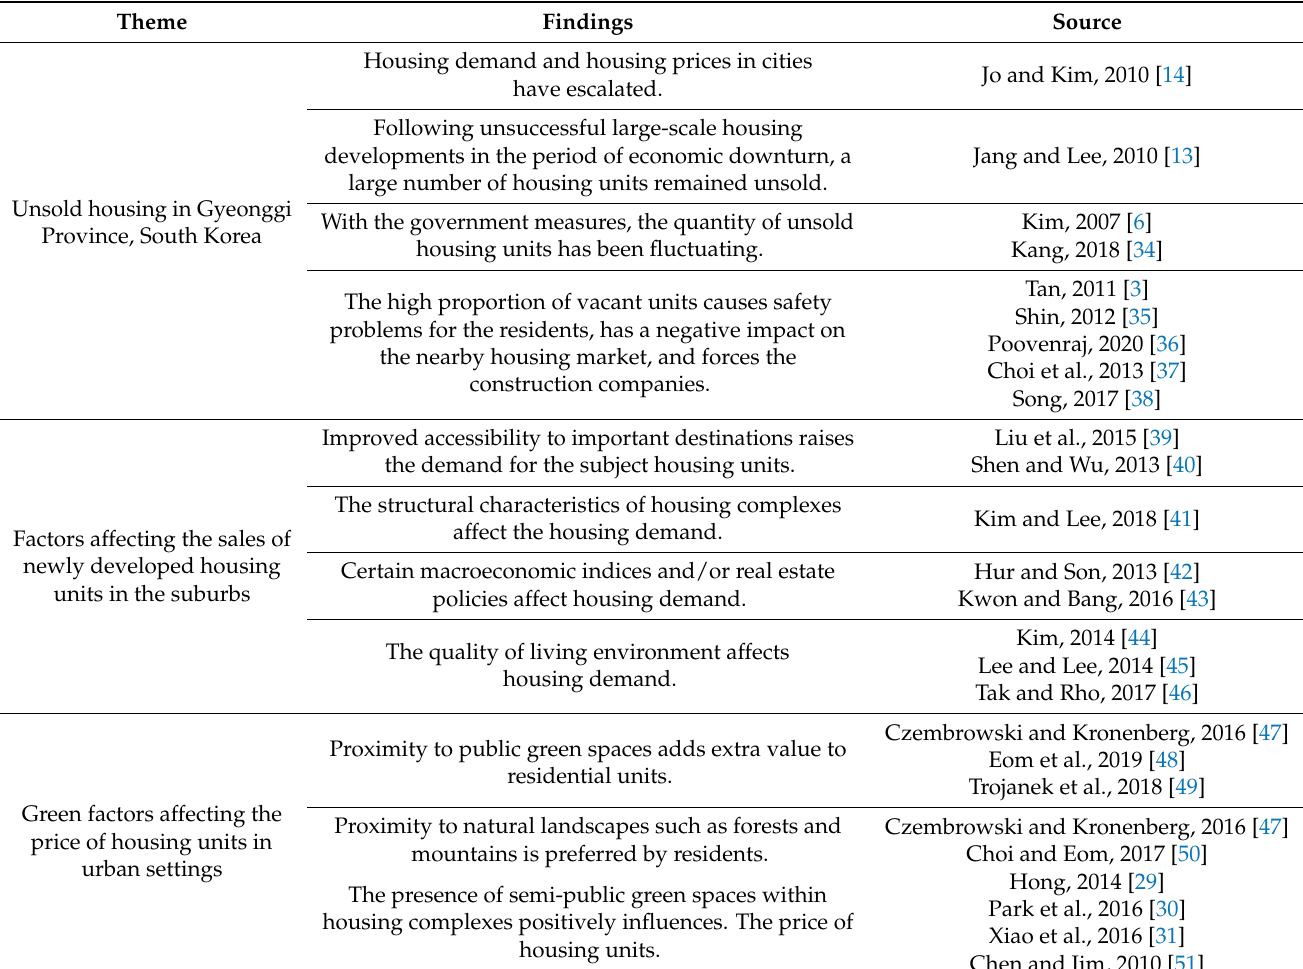
Table 1. Studies included in the literature